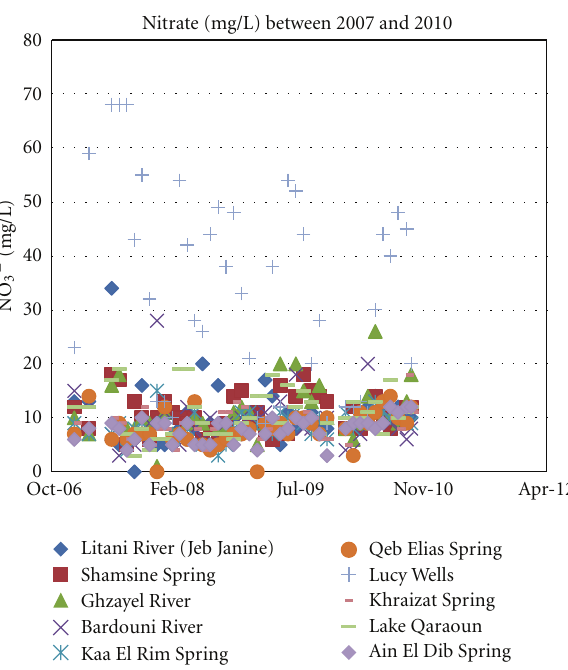
Figure 9: Nitrate concentrations for years 2007 through 2010.